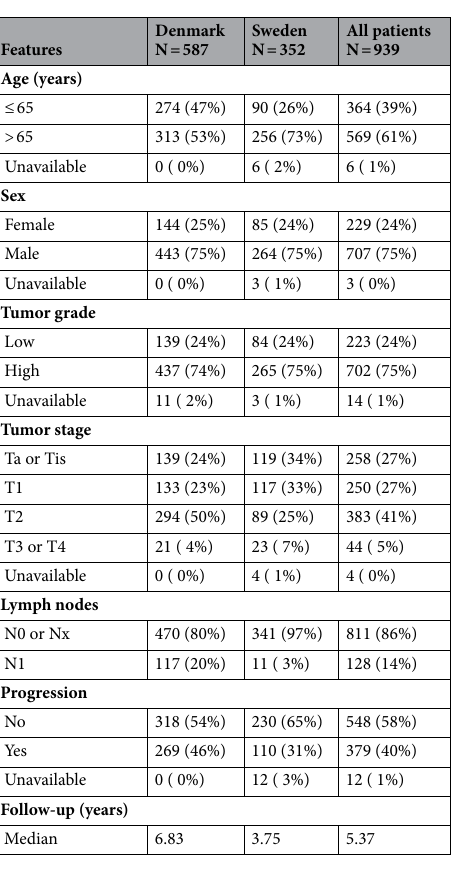
Table 1. Demographic, clinical, and pathologic characteristics of the 939 subjects comprising the study